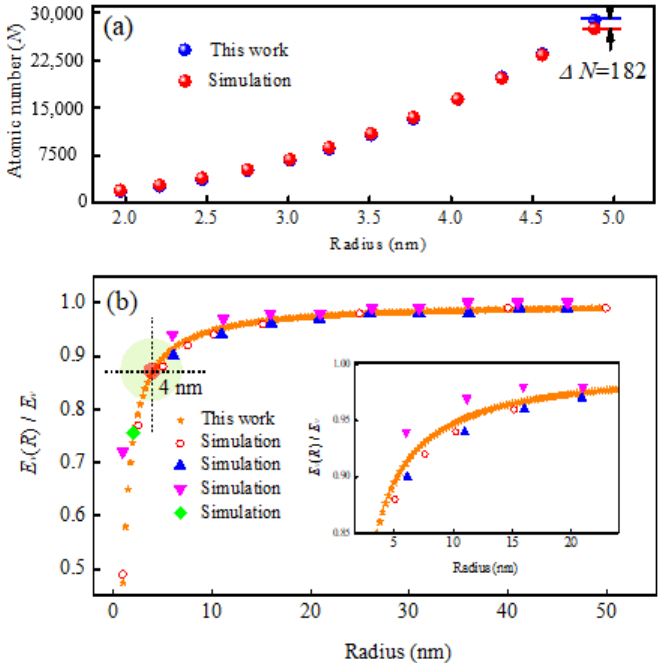
Figure 2. Relationship between particle size and ( a ) atomic number or ( b ) vacancy formation energy. (The detailed calculation parameters: CN is the coordination number 12, η is the packing coefficient 0.74, r 0 is the atomic radius 0.1442, R is the nanoparticle radius, ρ b / ρ n is density ratio 0.9, and the relevant data can be found in the supplementary materials Tables S1 – S5.)